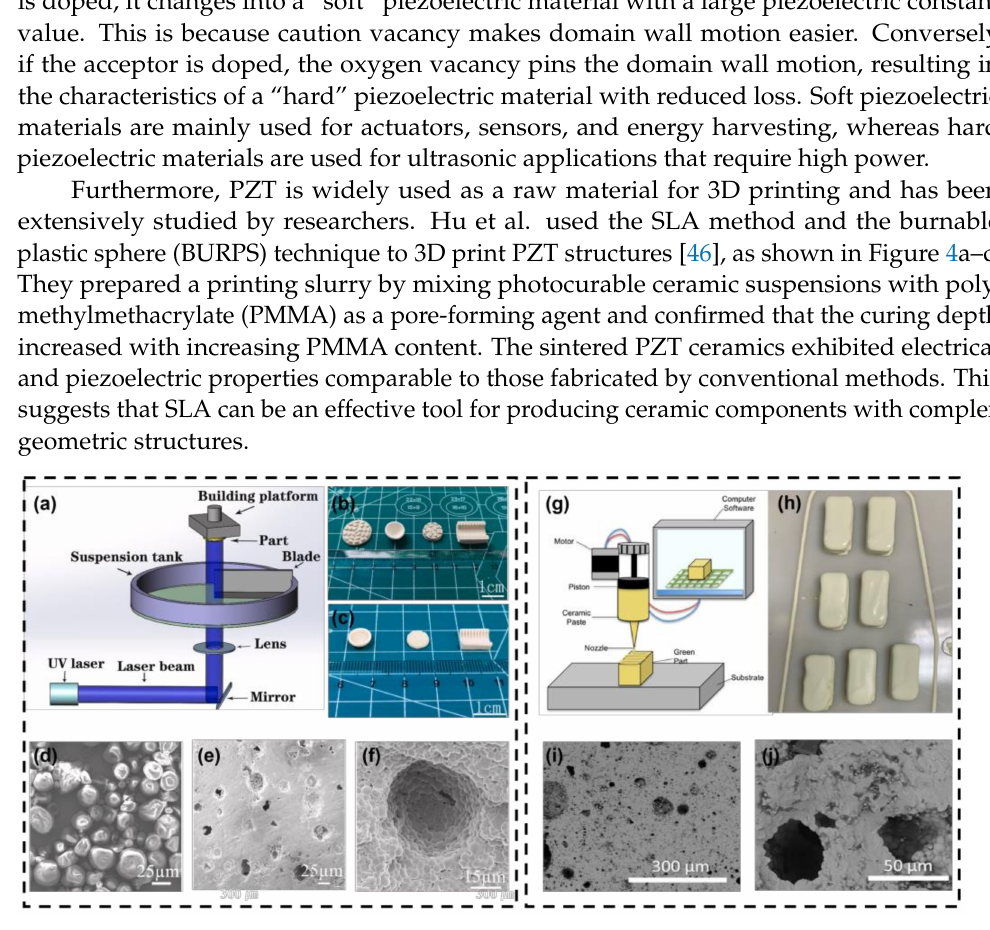
Figure 4. ( a ) The schematic of the SLA technique for 3D printing of PZT ceramics. Images of the 3D- printed ceramic arrays with various complex structures of ( b ) printed green bodies and ( c ) sintered ceramic parts. The SEM images of ( d ) PMMA particles, ( e ) surface morphology of the porous PZT ceramics fabricated by the SLA technique, and ( f ) magnified microstructure of a spherical pore [46] (Copyright 2021, Elsevier). ( g ) The schematic of the DIW method for PZT ceramics, ( h ) fabricated PZT ceramic green bodies, and the SEM images displaying ( i ) the top surface and ( j ) the cross-section of sintered sampled [47] (Copyright 2021,